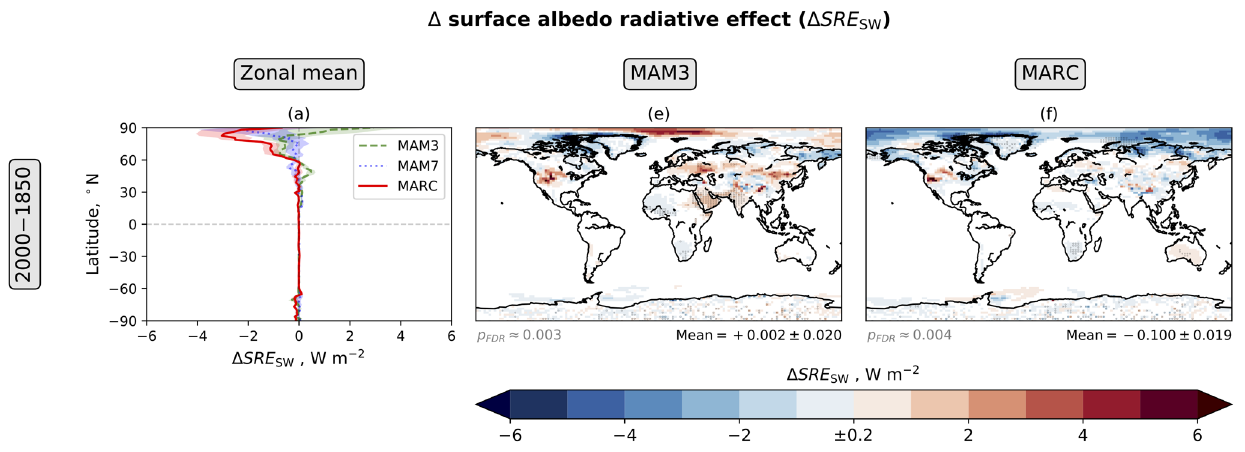
Figure 16. Annual mean aerosol-induced 2000–1850 surface albedo radiative effect ( (cid:49) SRE SW ; Eq. 5). The figure components are explained in the Fig. 2